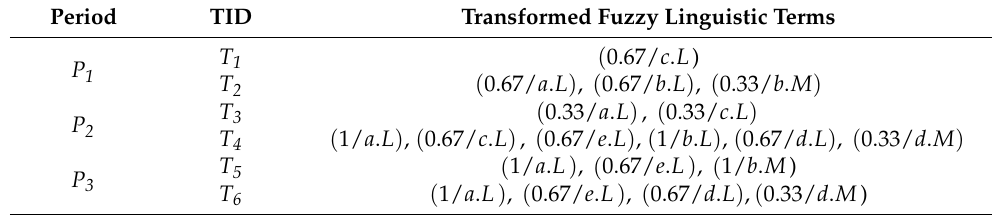
Table 6. The sorted revised